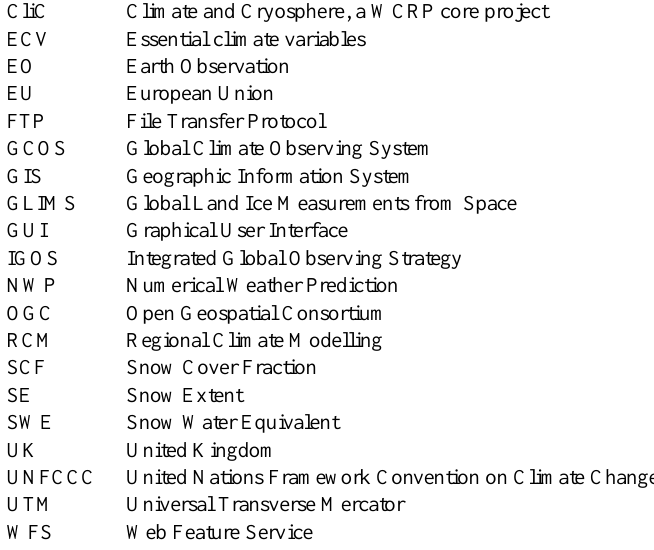
Table A1. Abbreviations used in the text. Mainly organizations and cryosphere-related